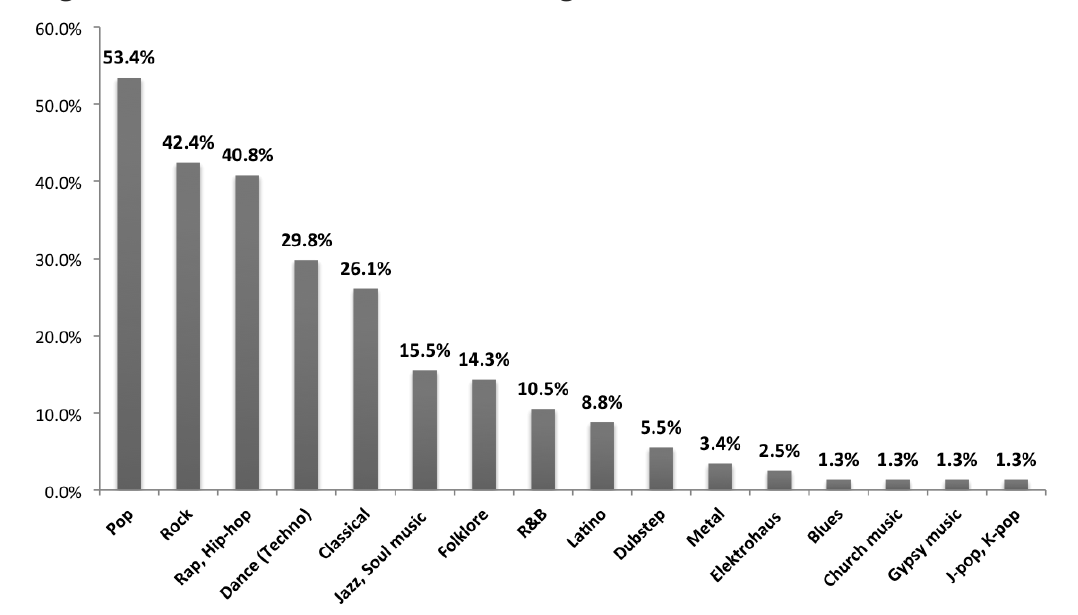
Fig. 2 . What kind of music listen Hungarian